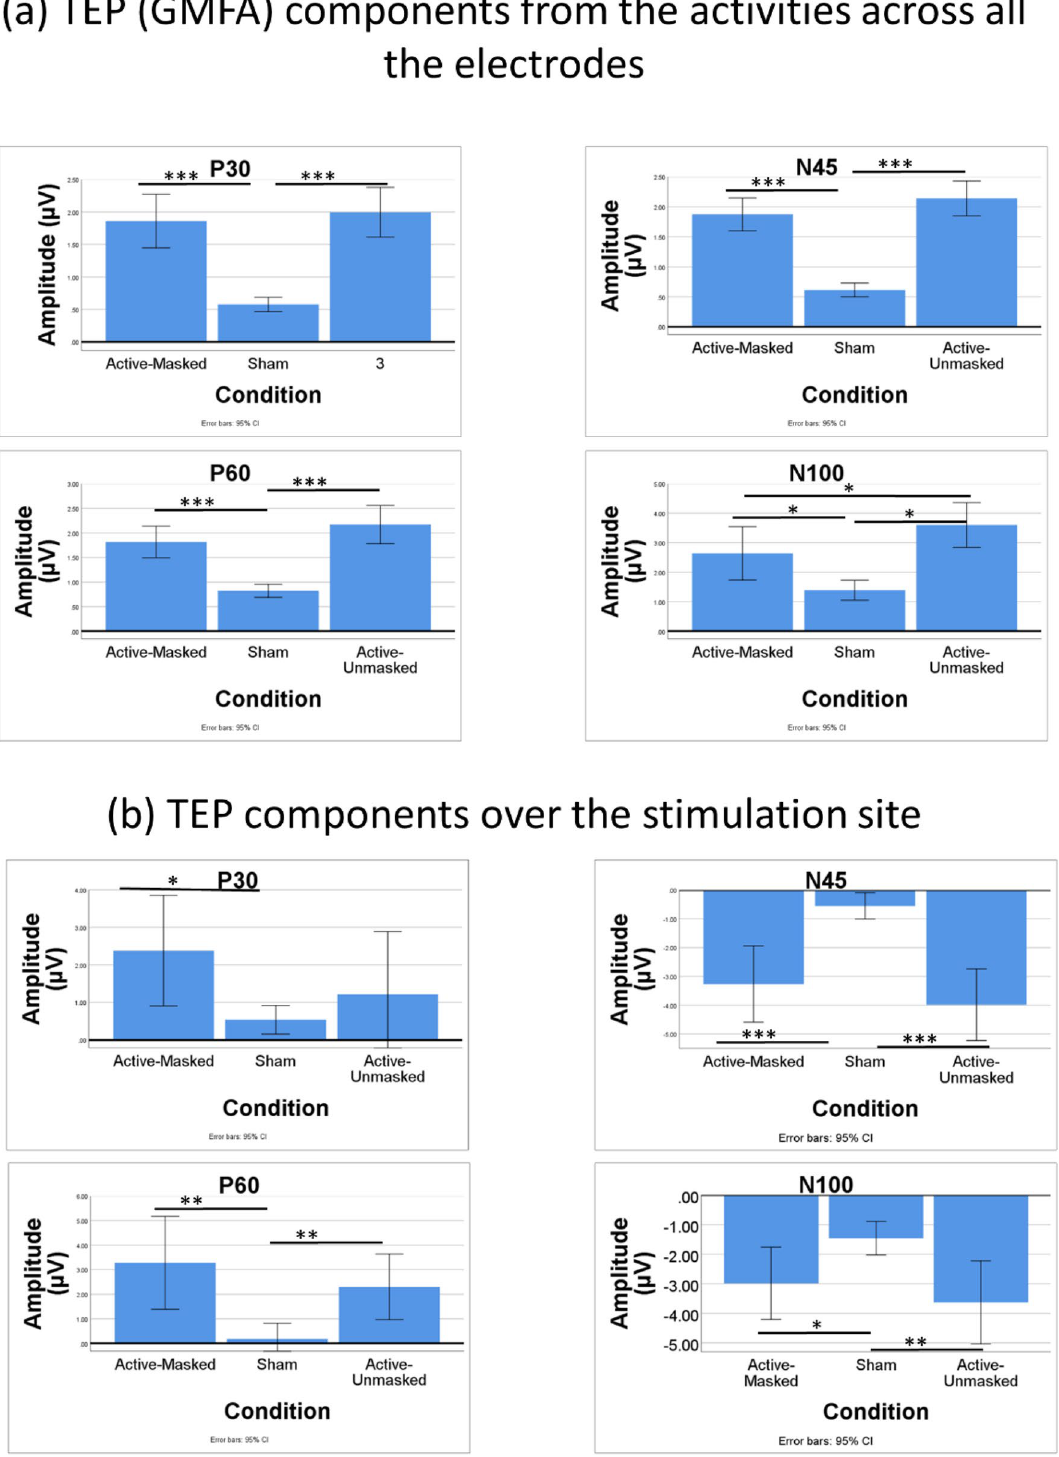
Figure 6. ( a ) TEP (GMFA) components from the activities across all the electrodes ( b ) TEP components over the stimulation site (* p < 0.05, ** p < 0.01, *** p <